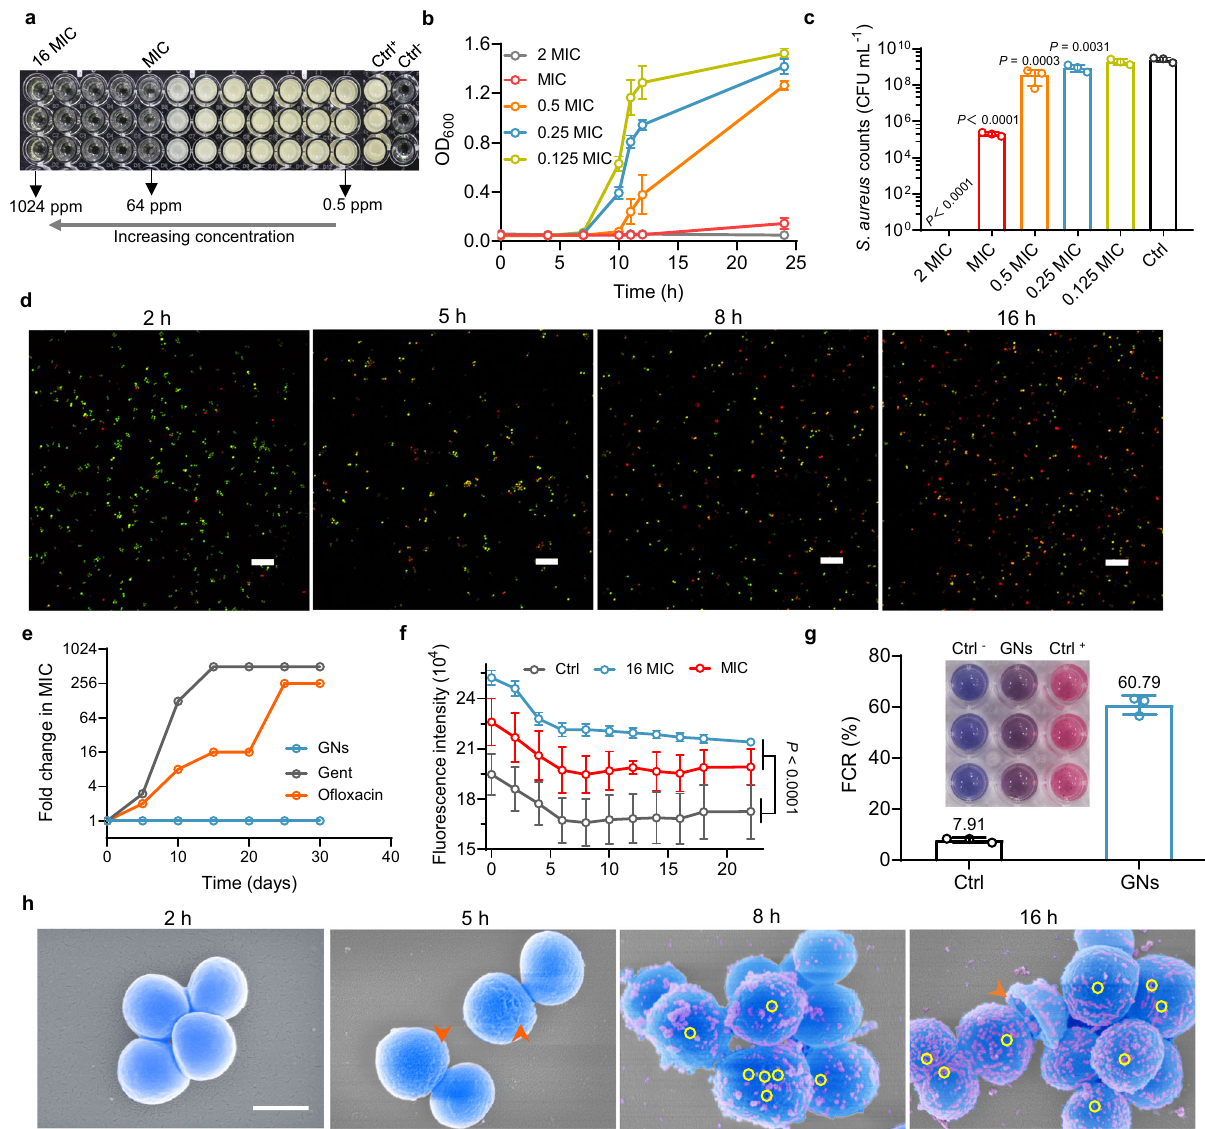
Fig. 4 GNs ef fi ciently eradicate Gram-positive bacteria. a The MIC test of GNs on S. aureus . b Growth curves of S. aureus at different GNs concentrations. c S. aureus strain counts calculated from spread-plate assays after treatment with different concentrations of GNs. d Representative live-dead fl uorescence staining of S. aureus with GNs (0.5 MIC) co-cultured for different time (2, 5, 8, and 16 h). Green fl uorescence stained by SYTO9 dye indicates live bacteria, and red fl uorescence stained by PI dye represents dead bacteria. Scale bar, 10 μ m. e Monitoring of drug resistant development of S. aureus after exposure to GNs, Gent, and O fl oxacin at sub-MIC concentrations over serial 30 passages. f GNs depolarized the cytoplasmic membrane. The cytoplasmic membrane depolarization activities were determined using the membrane potential sensitive dye DiBAC4(3). g Interaction of GNs with the model membrane systems after incubation for 24 h. Insert: Color transitions after the interaction of GNs and DMPE/DMPG/TRCDA (1:1:3) vesicles. Ctrl − and Ctrl + represent the negative and the positive control group, respectively. h Scanning electron microscope (SEM) images representing the morphologies and structures of S. aureus after GNs treated different time. Scale bar, 0.5 μ m. Data are presented as mean ± standard deviations from a representative experiment ( n = 3 independent samples). P values were analyzed by one-way ANOVA with Dunnett ’ s multiple comparisons post hoc test for c and f . Source data are provided as a Source Data fi